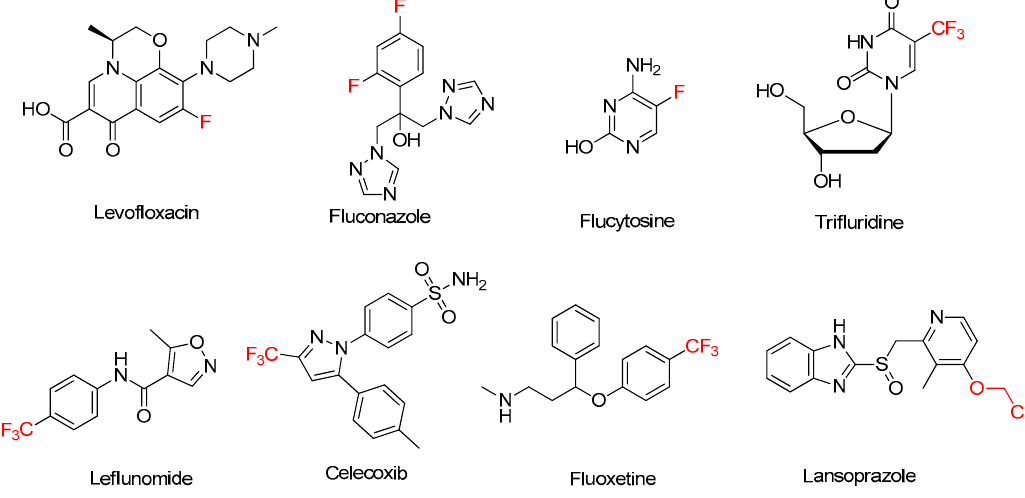
Figure 2. Structures of selected drugs containing one or more fluorine atoms.